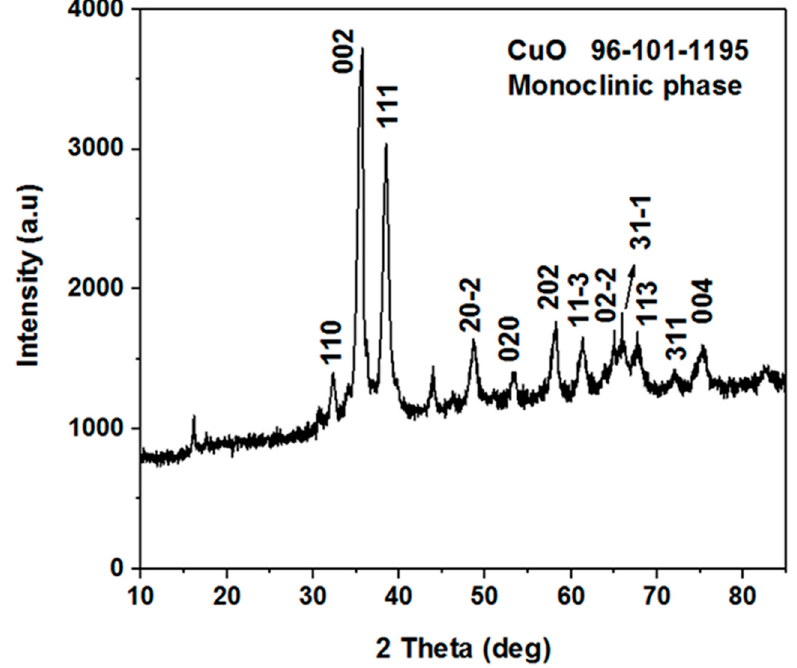
Figure 2. The XRD spectrum of the vitamin B 12 -assisted CuO nanomaterial.